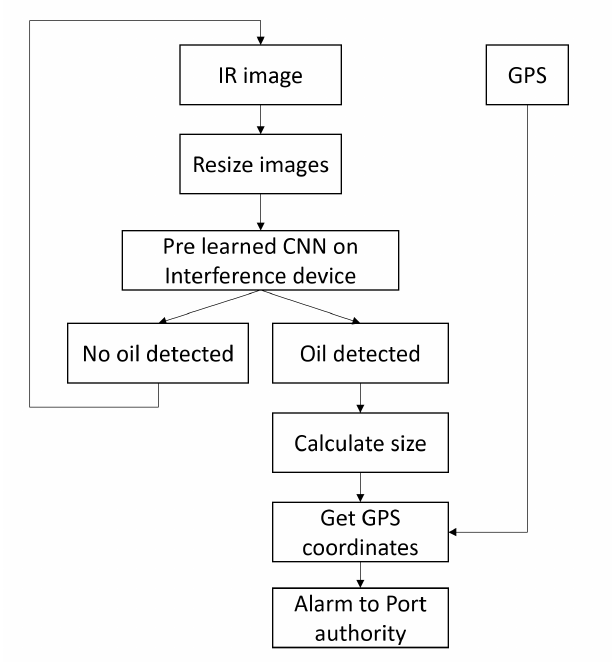
Figure 2. Flow chart of the operational